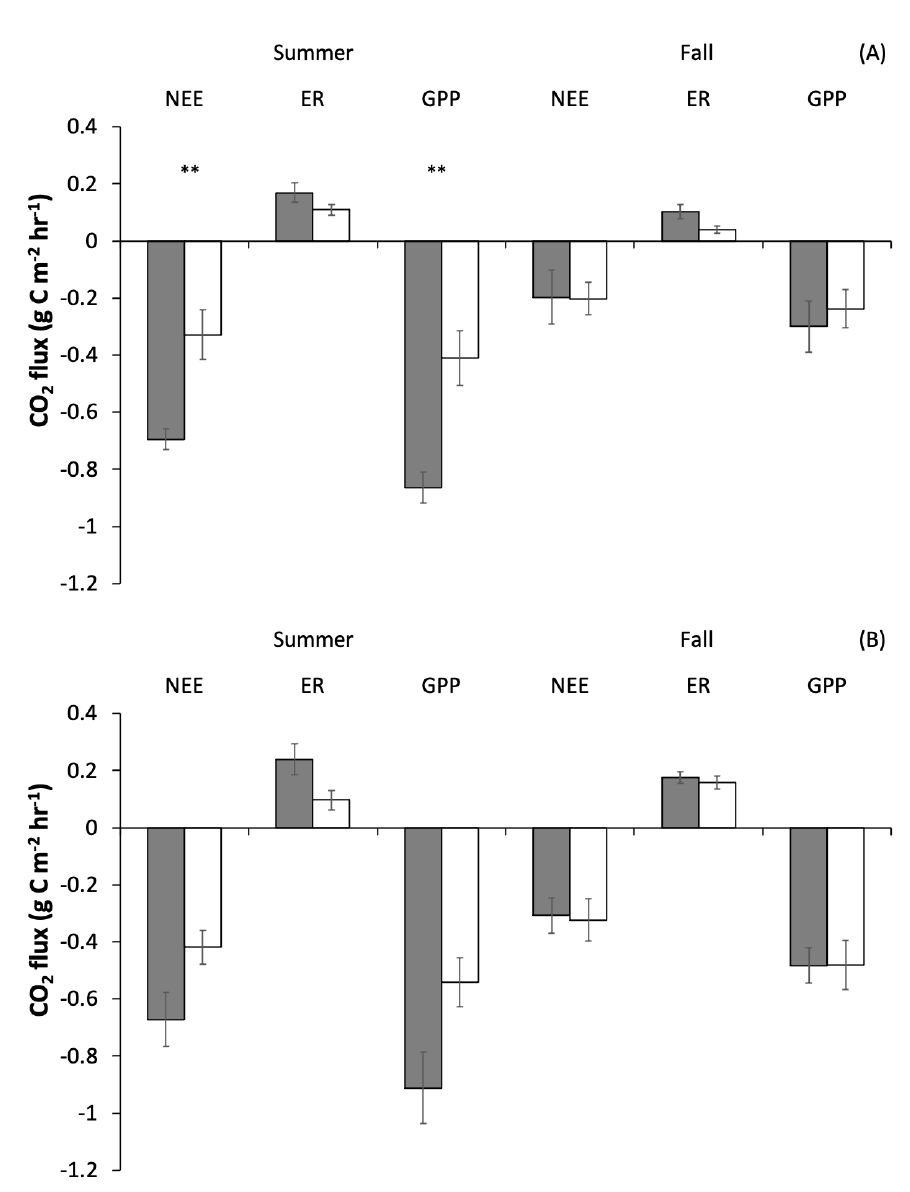
Figure 4. Net ecosystem exchange (NEE), ecosystem respiration (ER) and gross primary produc- tion (GPP) in 2017 ( A ) and 2018 ( B ) for caged (grey) and uncaged (white) treatments. Summer measurements were taken in the period June–July, fall measurements were taken in the period August–September. Stars indicate significant differences between caged and uncaged plots ( p < 0.05) within a season, where there was a significant interaction between season and